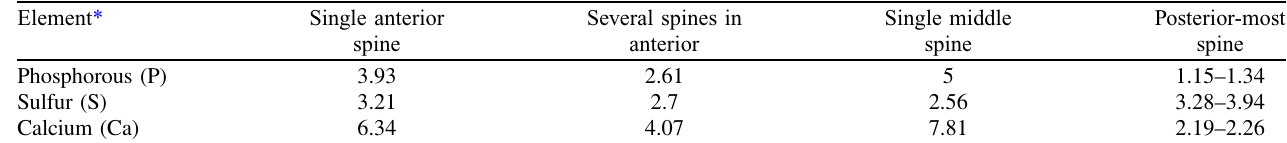
* Palladium (Pd) and gold (Au) were used to count the specimens and gallium for the cross cut of the spines. These and other elements (C, O, N) common in organic matter are omitted. Data are reported in weight